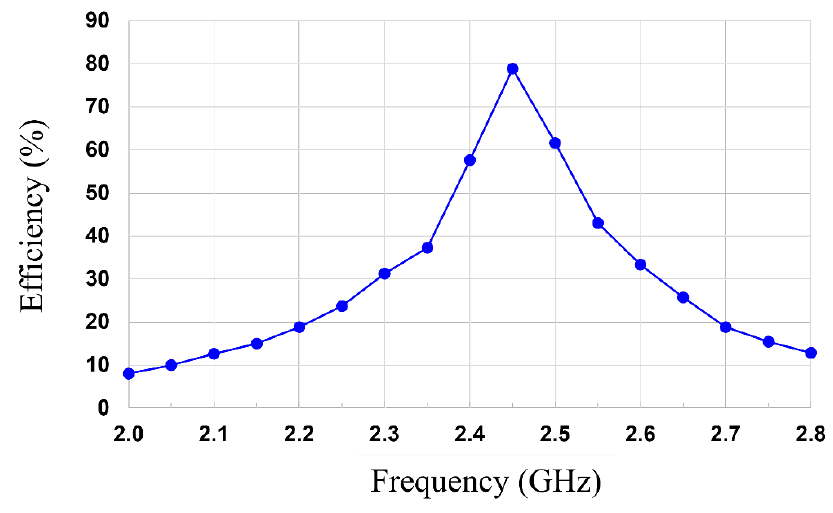
Figure 15. Measured RF–DC conversion efficiency versus frequency of the MTM-integrated rectenna.